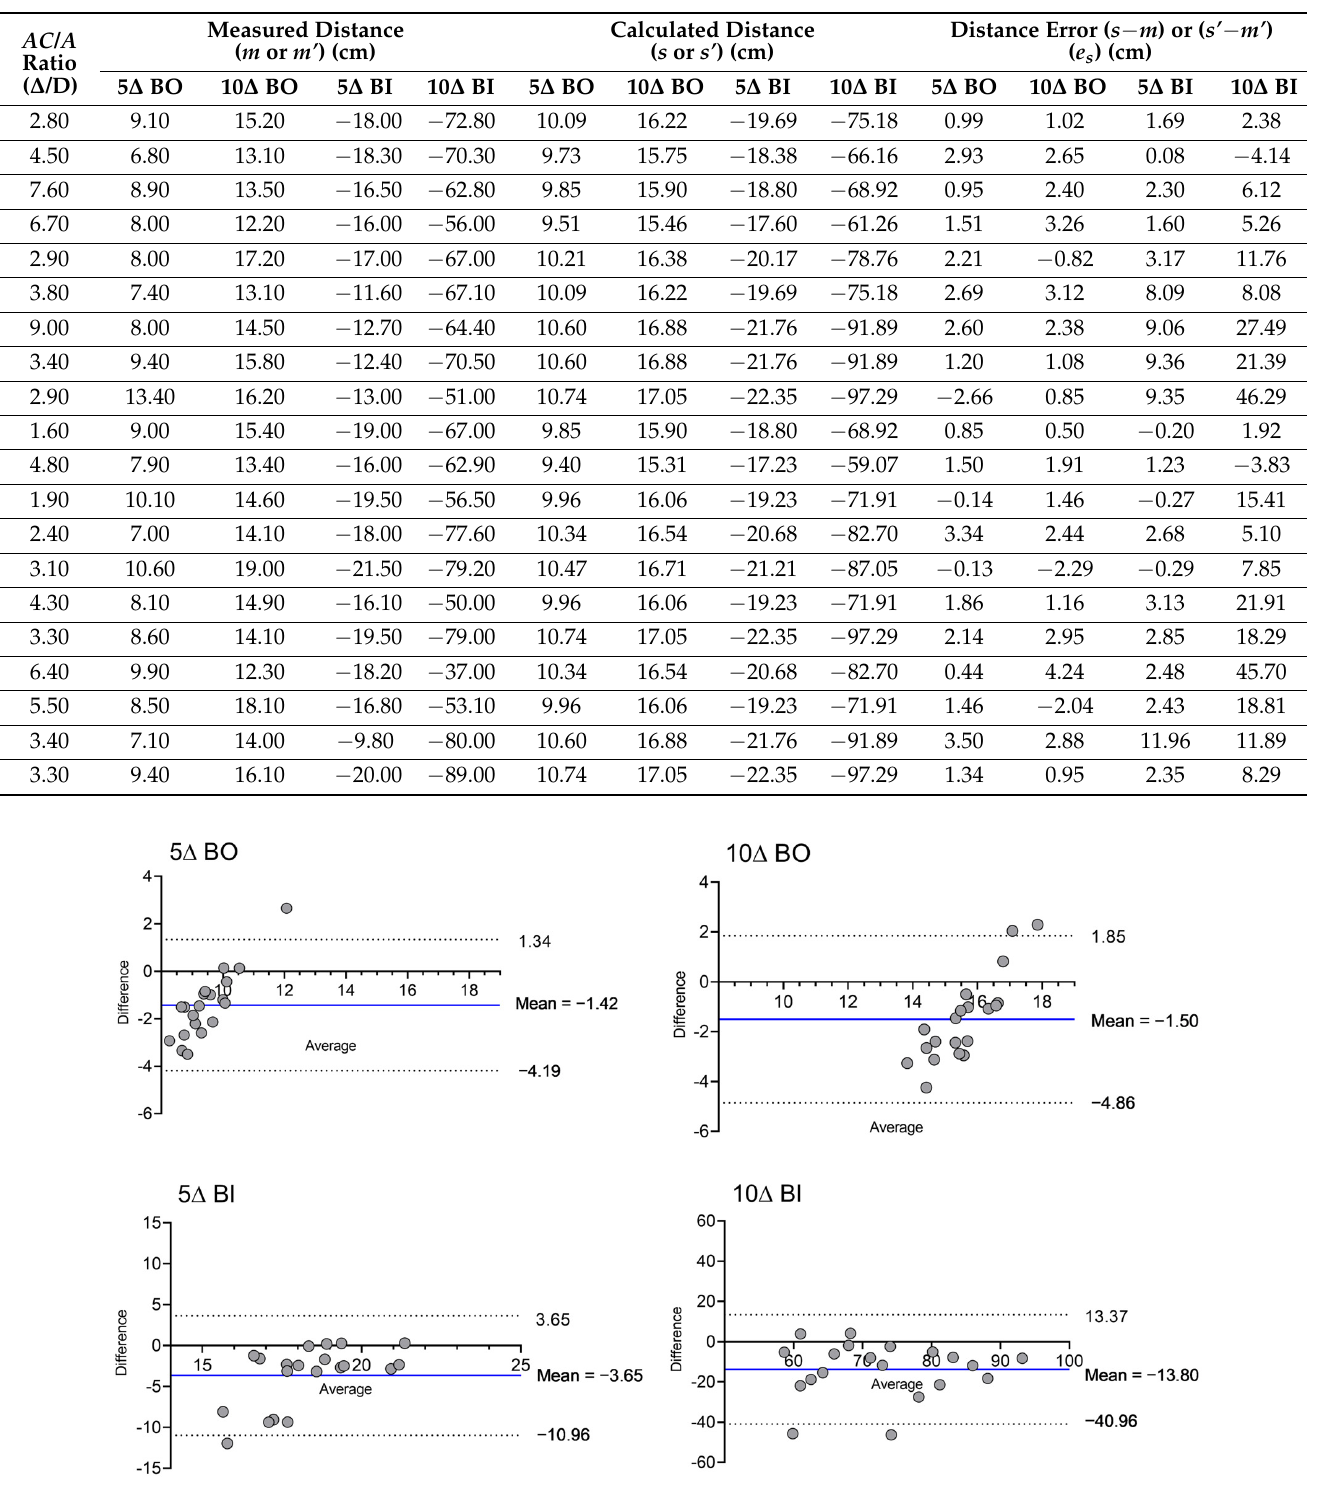
Table 2. Measured and calculated distance to the perceived stimuli under each convergence ( m and s ) and divergence ( m’ and s’ ) demand and distance error values ( e s ) for each participant. Convergence corresponds to Base Out (BO) and divergence to Base In (BI) prisms.